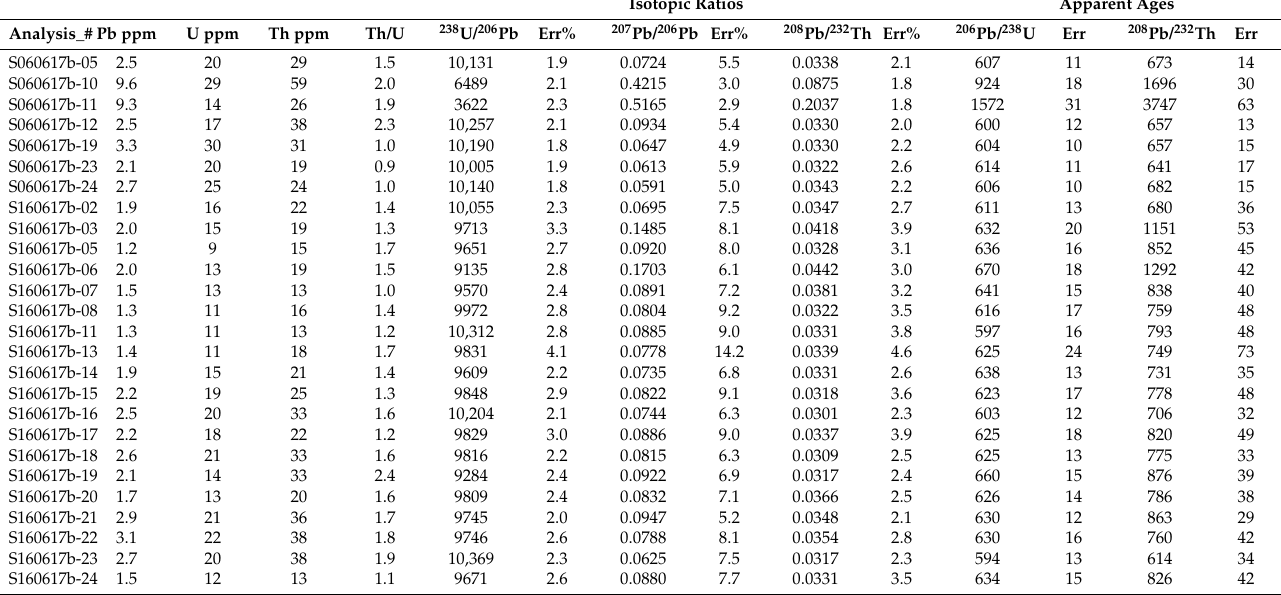
Table 2. LA-ICP-MS U-Th-Pb data on bastnaesite standardized with Monazite Standard Moacyr. Isotopic Ratios Apparent